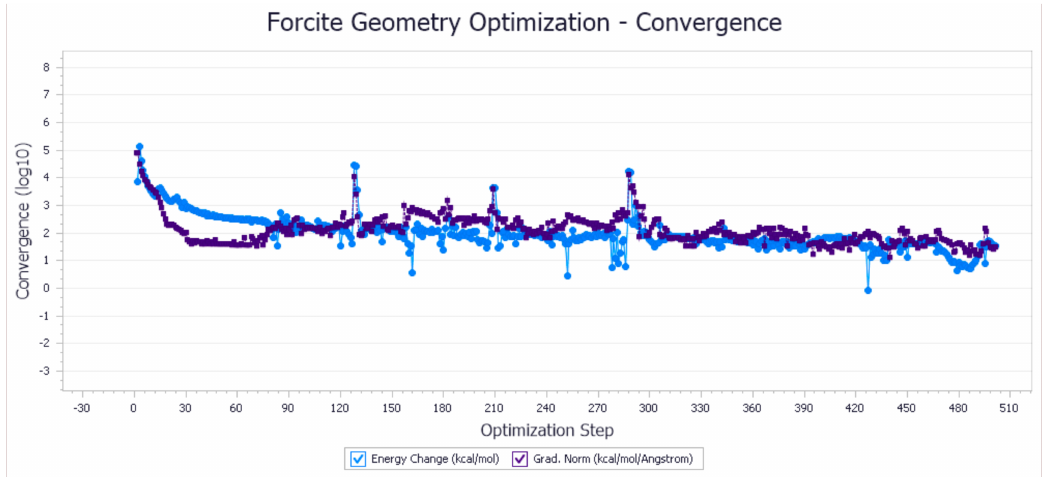
Figure 11. Demulsifier8 # oil–water interface geometric optimization steps.